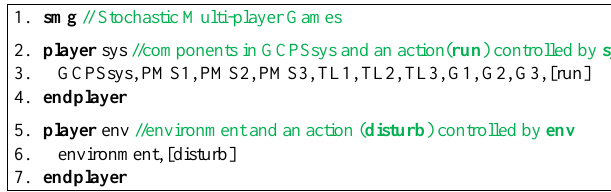
Figure 9. Part of the transformed SMG model of an aircraft power